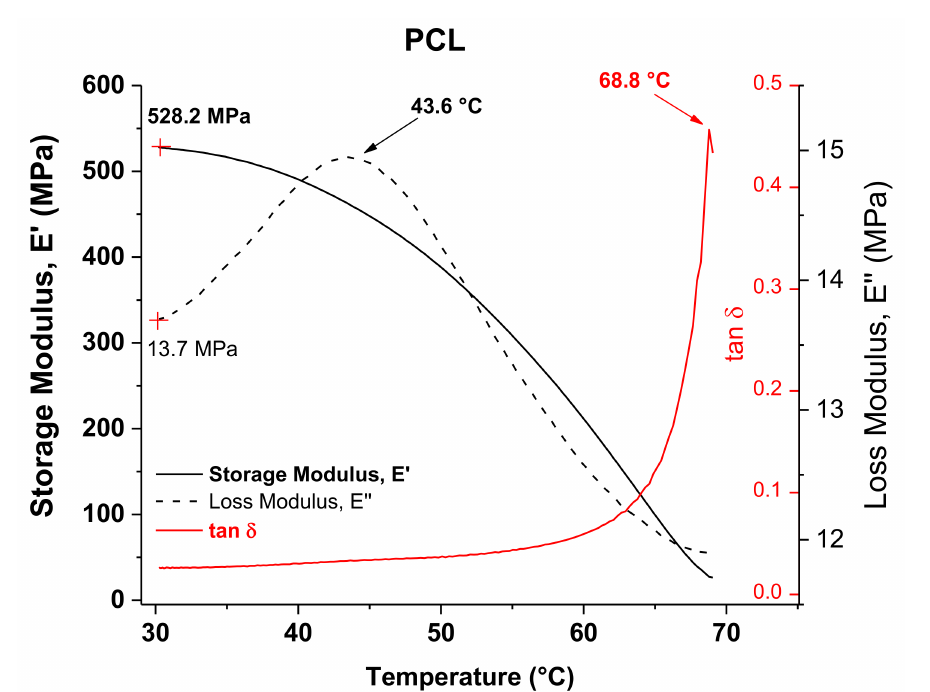
Figure 5. DMA graphs of